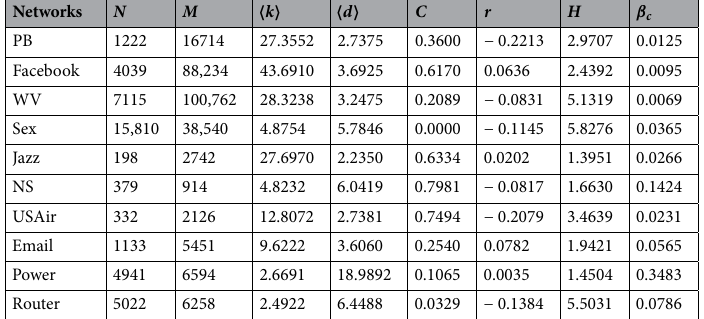
Table 6. The basic topological features of the ten real networks.